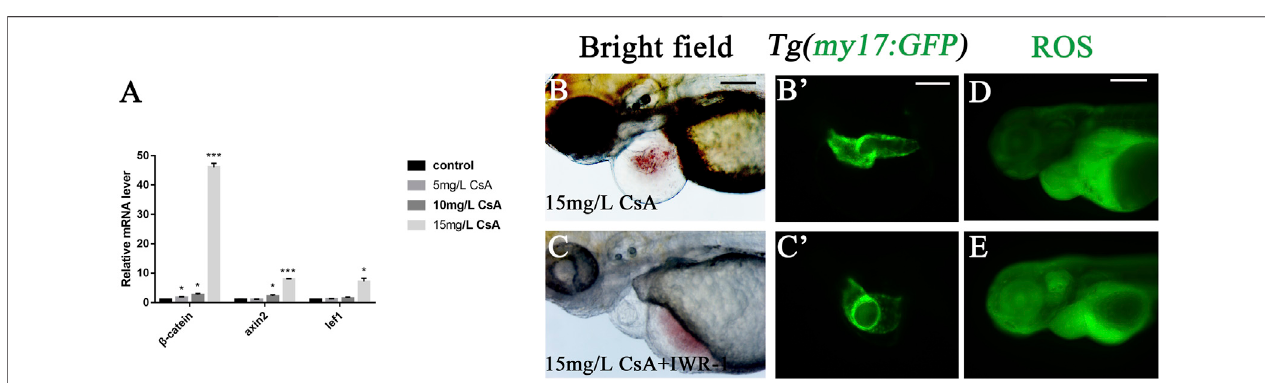
FIGURE 7 | IWR-1 rescued cardiac development defects induced by CsA exposure. (A) The up-regulation of β -catenin, lef1 and axin2 in the heart of 72 hpf zebra fi shexposedto15 mg/LCsA(Comparedwithcontrol:* p < 0.05,** p < 0.01,mean ± SD). (B-C) IWR-1rescuedheartdefectsin72 hpfzebra fi shexposedtoCsAat 15 mg/L. (D-E) IWR-1 rescued ROS staining in 72 hpf zebra fi sh exposed to CsA at 15 mg/L. Scale bars:100 µm ( B-E ).